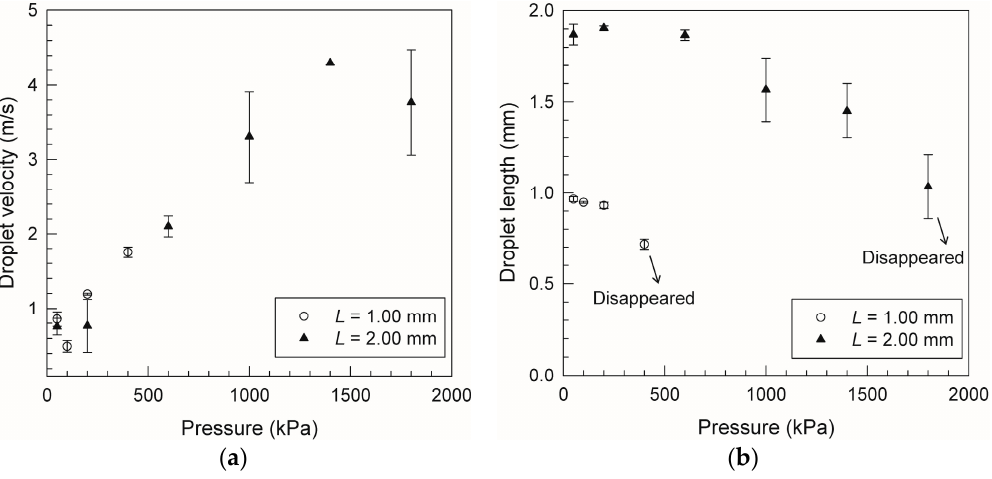
Figure 4. ( a ) Velocity and ( b ) length of droplet as function of applied pressure in microchannels of L = 1.00 mm and L = 2.00 mm. Error bars represent the standard deviation of triplicate measurements.